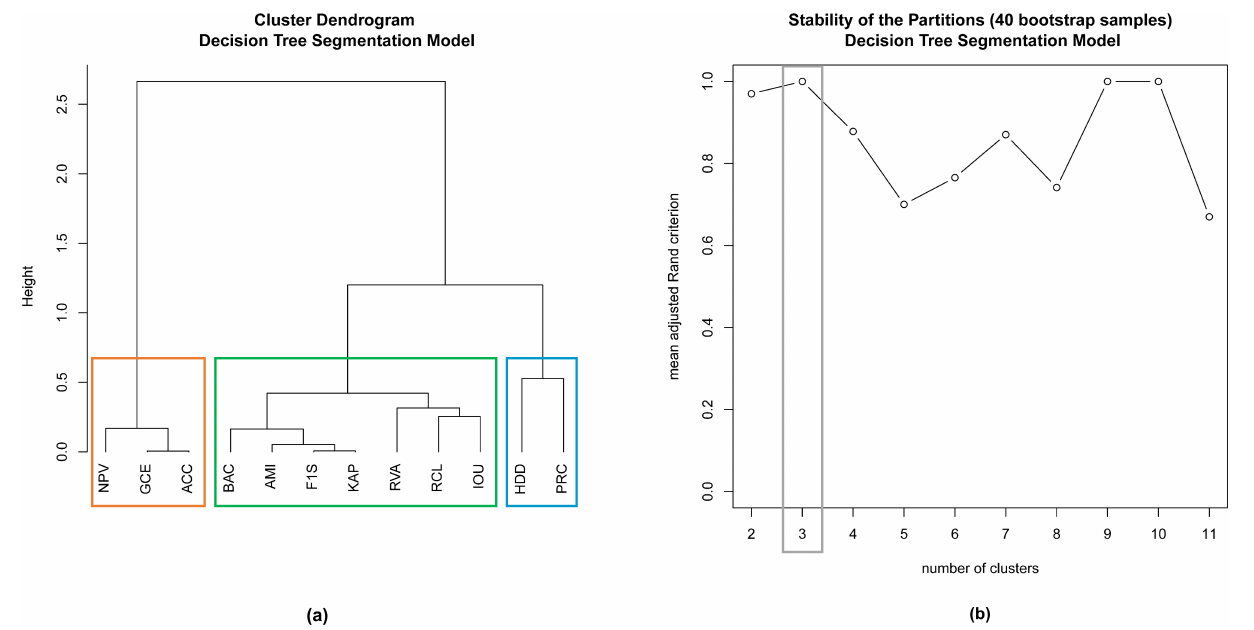
Figure 4. ( a ) Dendrogram resulting from hierarchical clustering. Height ( y -axis) represents the loss in homogeneity. ( b ) Measure of stability over 40 bootstrap samples in comparison with initial clustering: we can see that the partitioning is most stable at 3